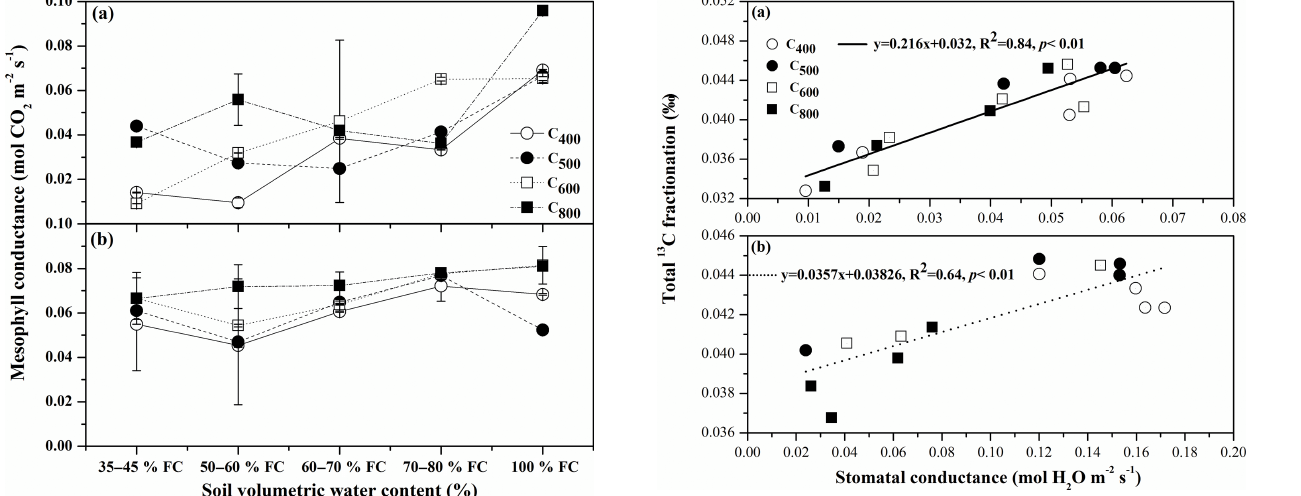
Figure 6. Mesophyll conductance in P. orientalis (a) and Q. vari- abilis (b) for four CO 2 concentration × five soil volumetric water content treatments. Means ± SDs, n = 32.